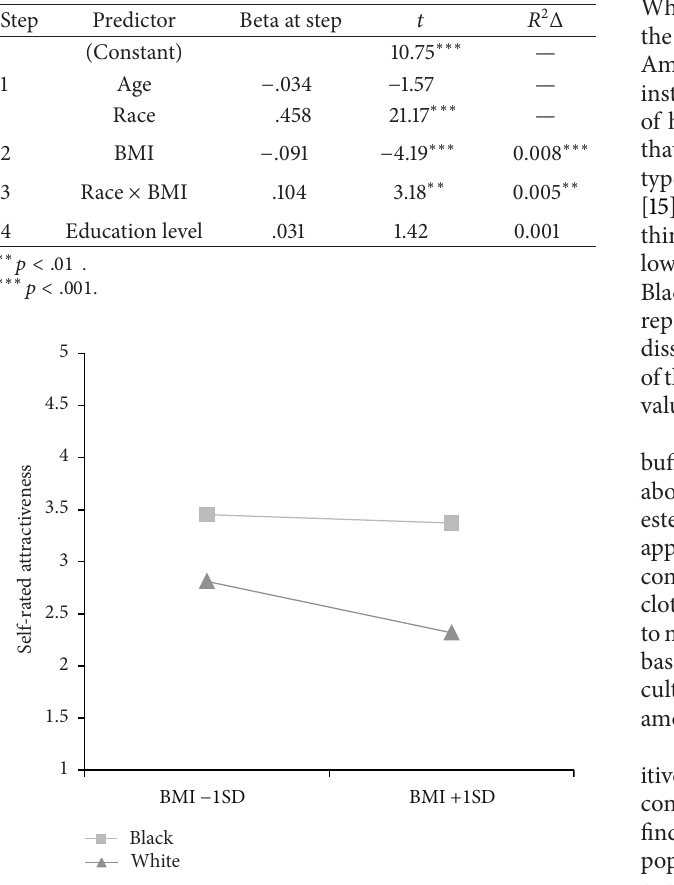
Table 2: Perceived attractiveness as a function of race.